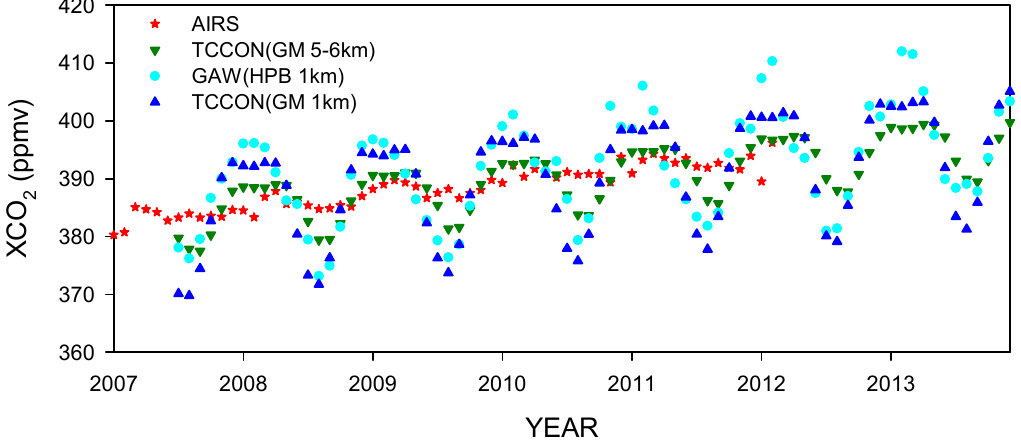
Figure 9. Comparison of monthly average variation and tendency of CO 2 concentrations among the